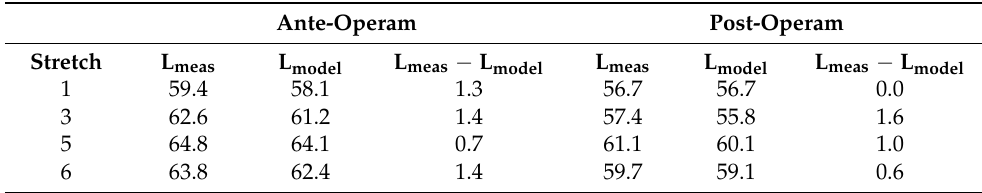
Table 12. L n values ante- and post-operam in Massarosa. Levels in dB(A). Ante-Operam Post-Operam Stretch L meas L model L meas − L model L